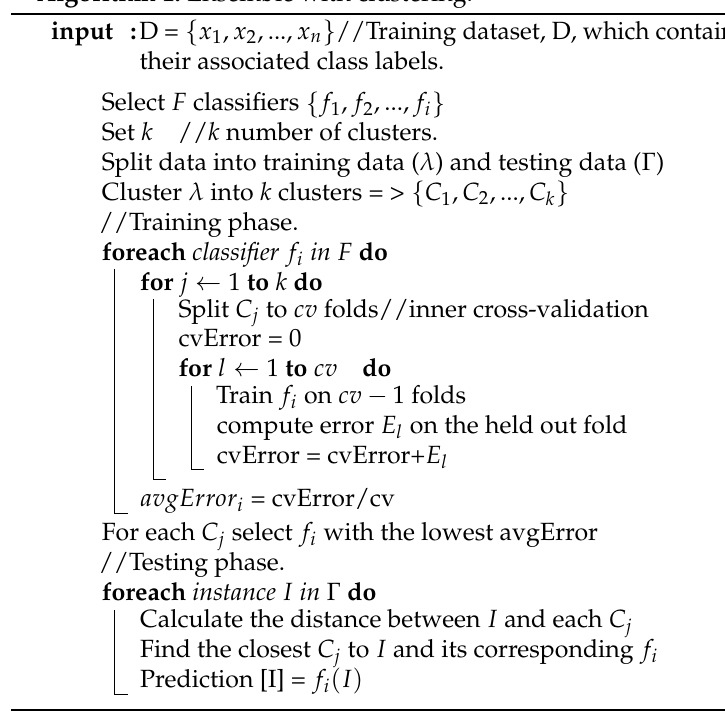
Algorithm 1: Ensemble with